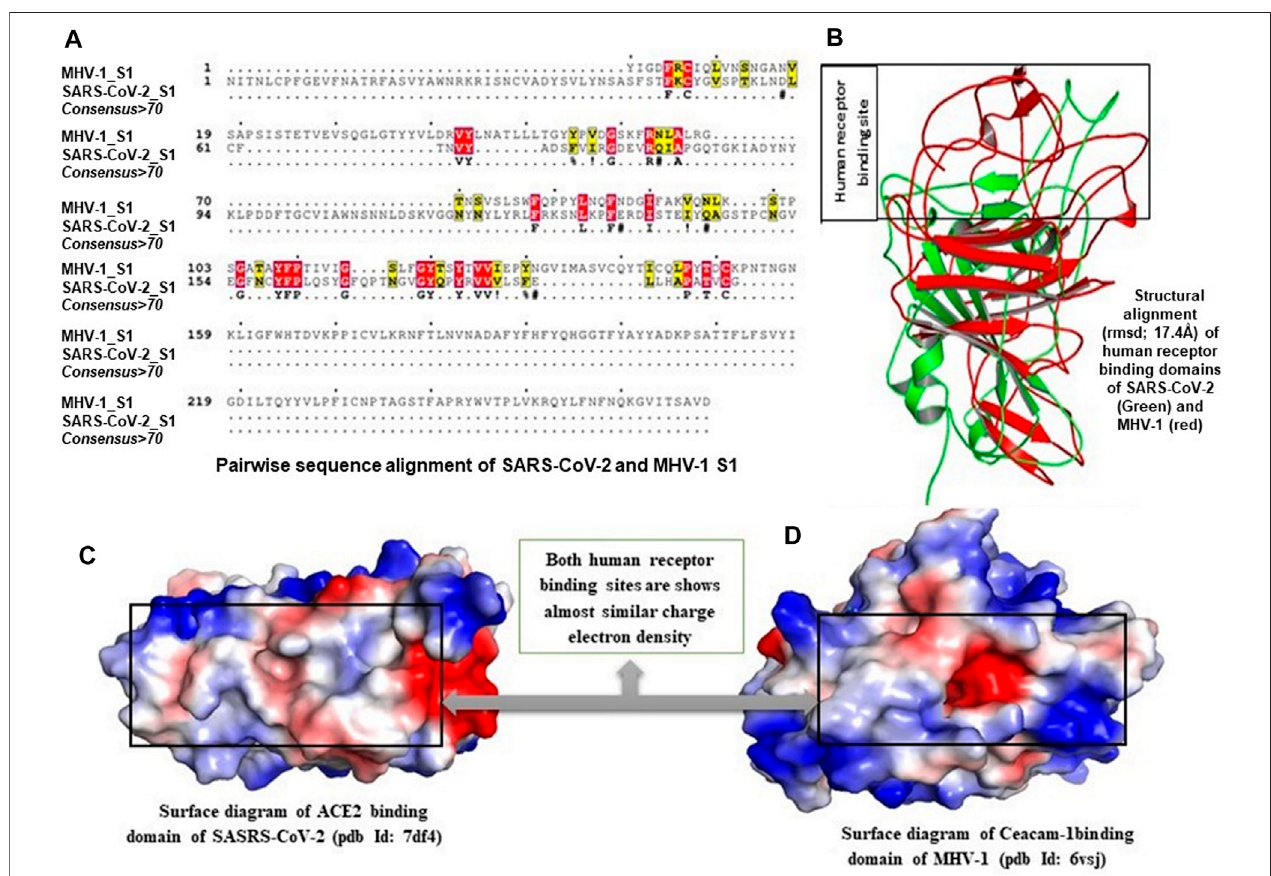
FIGURE 3| Multiple sequence alignment (MSA) ofhuman receptor binding domains (RBDs) from COVID-19 and N-terminaldomain (NTD) from MHV-1 are shown in (B) , which con fi rms that both these domains share less than 12% sequence similarity, which suggests that both these structures are dissimilar. Moreover, structural alignment of the RBDs and NTDs of viral spike proteins showed a root mean square deviation (RMSD) of 17.4 Å (A) , which also strongly supports the structural dissimilarity, but they hold the β -sheets in their core structure. Interesting to note, the investigation of both human receptor binding sites by the creation of an electrostatic surface diagram revealed thatthe structuresare dissimilar,but receptor binding sites of both the structures have almost similar,highly hydrophobic binding environments (C,D) . Hence the ability of both these domains to strongly bind with